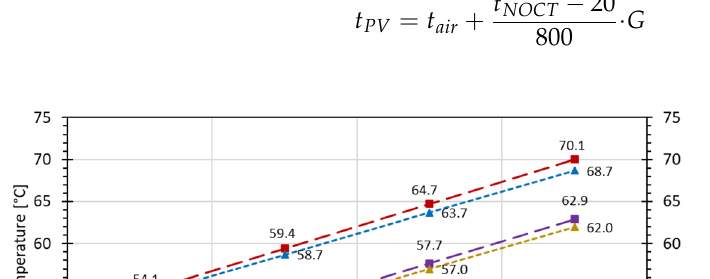
Figure 6. Validation of the numerical simulation—base case—PV panel without heat sink. 4.2. PV Panel and Heat Sink Validation The heat sinks attached to a PV panel were also analyzed for validation. The compar ‐ ison between experimental data [34] and the present model is presented in Figure 7.